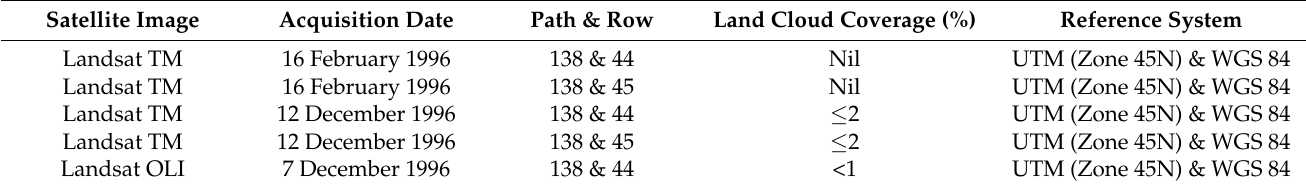
Table A1. Details of the satellite images used in the present study.